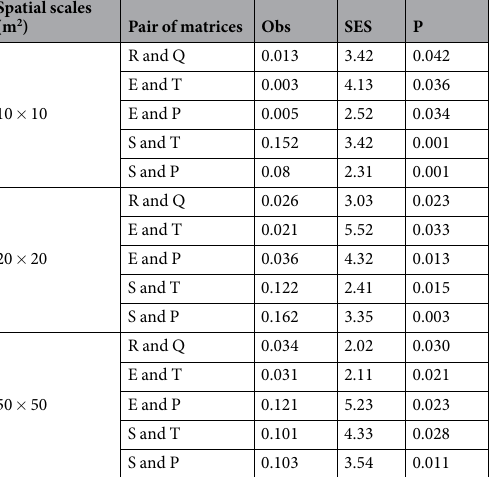
Spatial scales (m 2 )